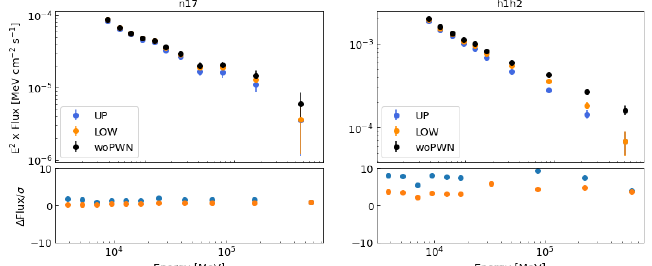
Figure 2. Spectral energy distribution (SED) of the cloud (left) and its surrounding medium (right) obtained including the lower (orange) and upper (blue) limit for the unresolved sources in the model. Black points show the SED obtained without including the unresolved contribution. In the lower panels we show the di ff erence from the spectral points obtained with and without the contribution of unresolved sources in the lower- and upper-limit case, as a fraction of the statistical